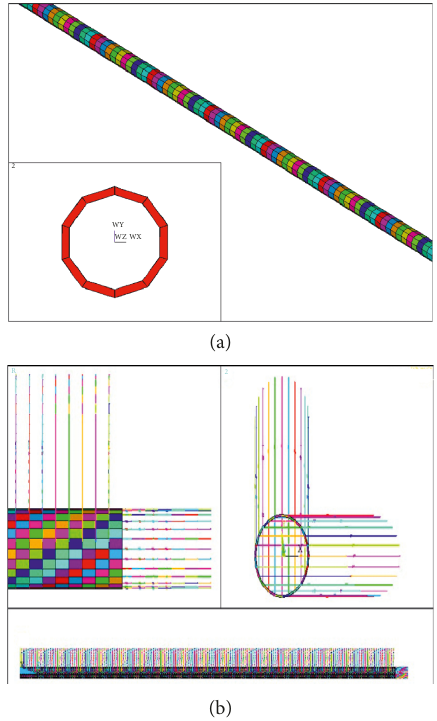
Figure 2: Three-dimensional finite element model of the gas storage well string. (a) Finite element model of injection and production string. (b) Mesh result of the finite element